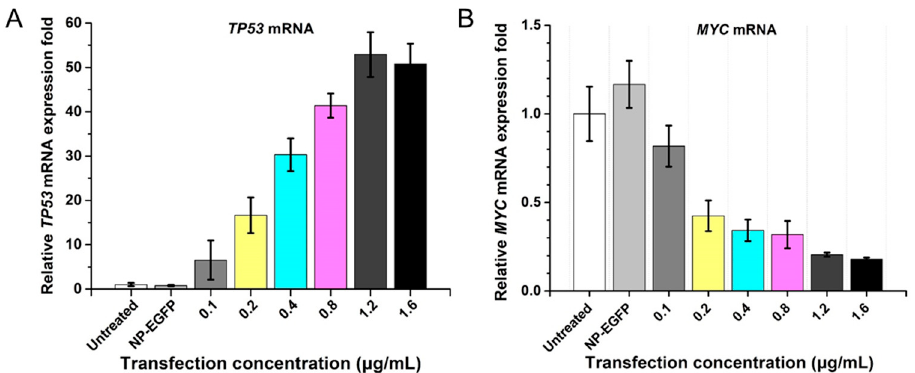
Figure 3 . NP-TP53-shMYC induced simultaneous TP53 overexpression and MYC gene knockdown in breast cancer cells. ( A ) The histogram of the relative expression fold of TP53 mRNA; ( B ) the histogram of the relative expression fold of MYC mRNA. The relative expression fold was quantified by RT-qPCR. NP-TP53-shMYC nanovectors at different concentrations were transfected into MDA-MB-231 cells for 48 h.